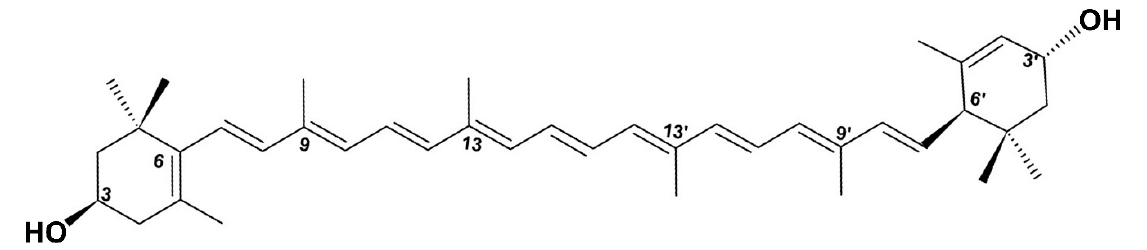
Figure 1. Chemical structure of dietary xanthophyll carotenoid, all- trans lutein assigned as (3R,3R ′ ,6 ′ R)-lutein.